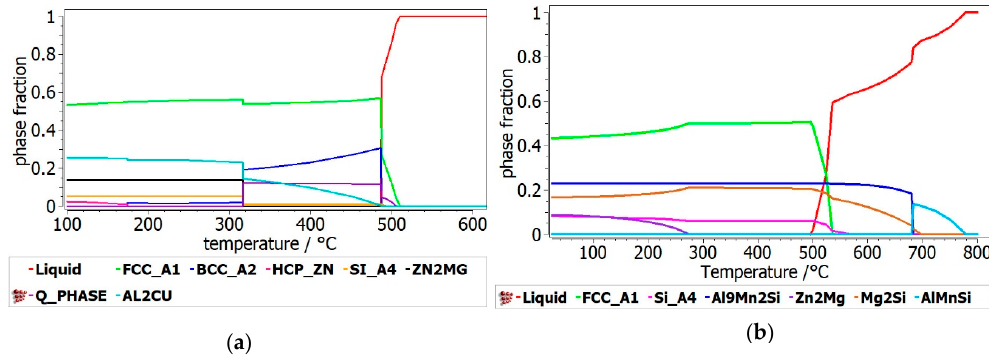
Figure 5. Phase composition versus temperature for the ( a ) Al 3.4 Cu 0.5 Si 0.2 Zn 0.5 Mg 0.2 and ( b ) Al 3 Mn 0.2 Zn 0.3 Mg 0.7 Si 0.8 alloys.